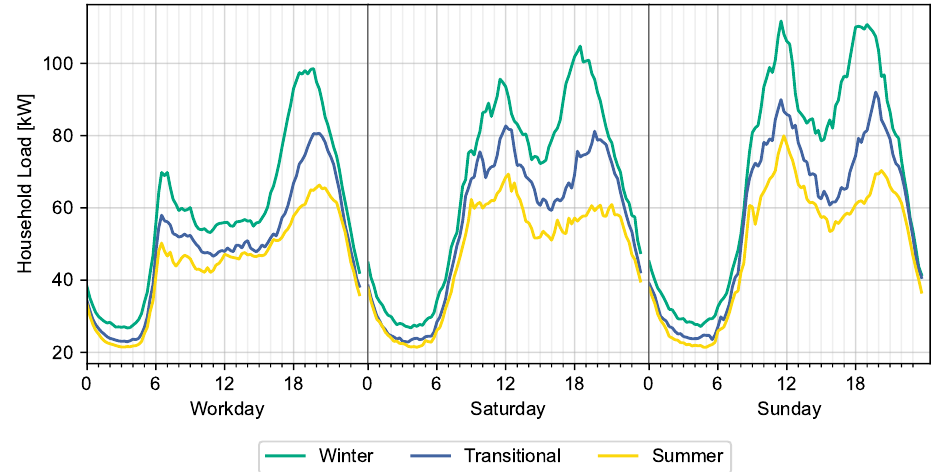
Figure 9. Aggregated average for electricity household load per type day and season.